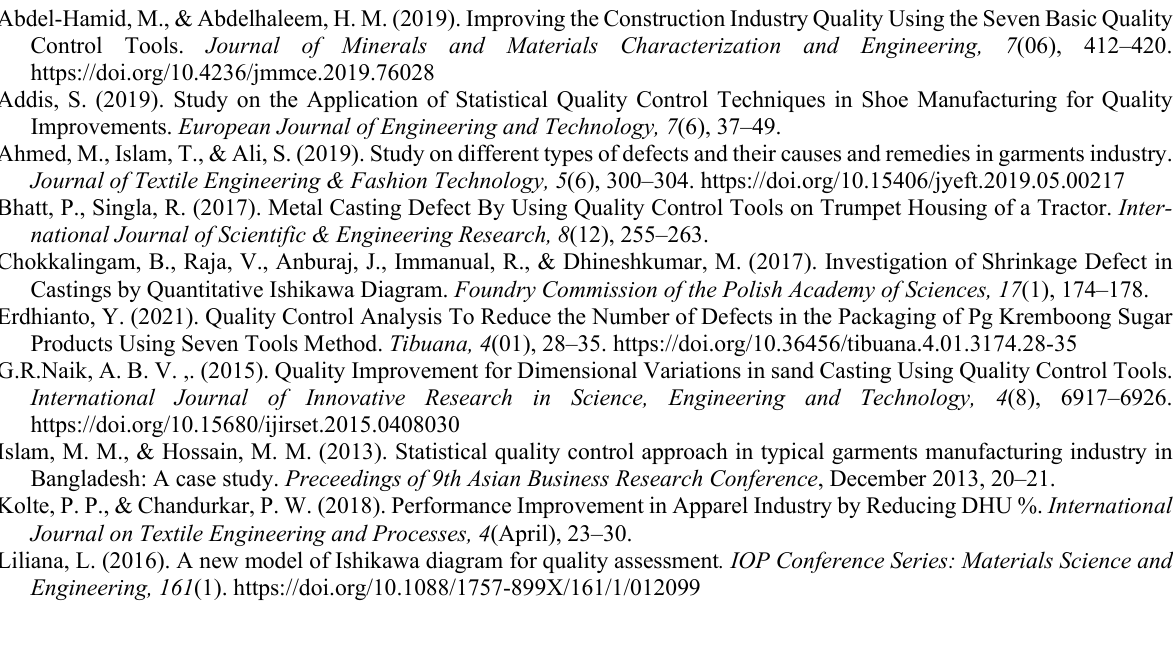
Total number of exports re- Number of saved shirts jected shirts per month after from defects after implementation of suggested solutions